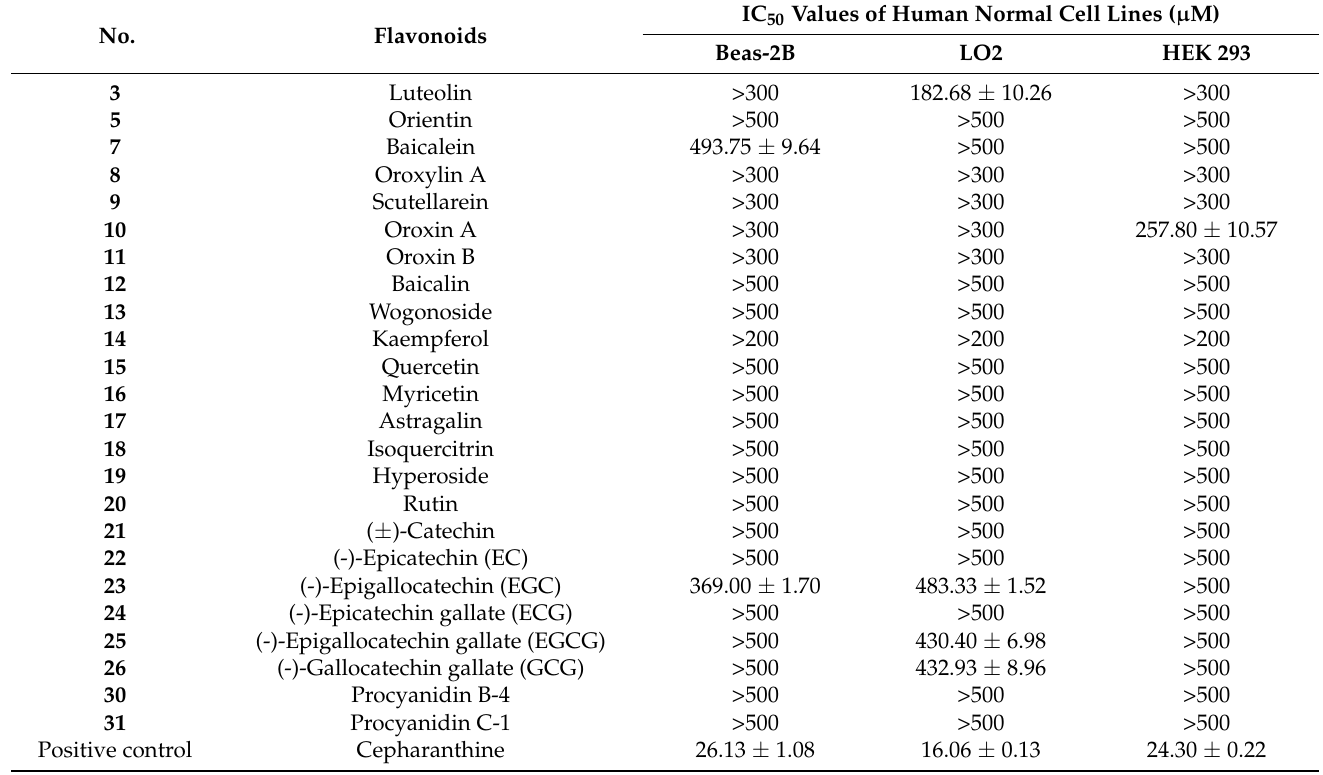
Table 3. Cytotoxicity of flavonoids on human normal cell